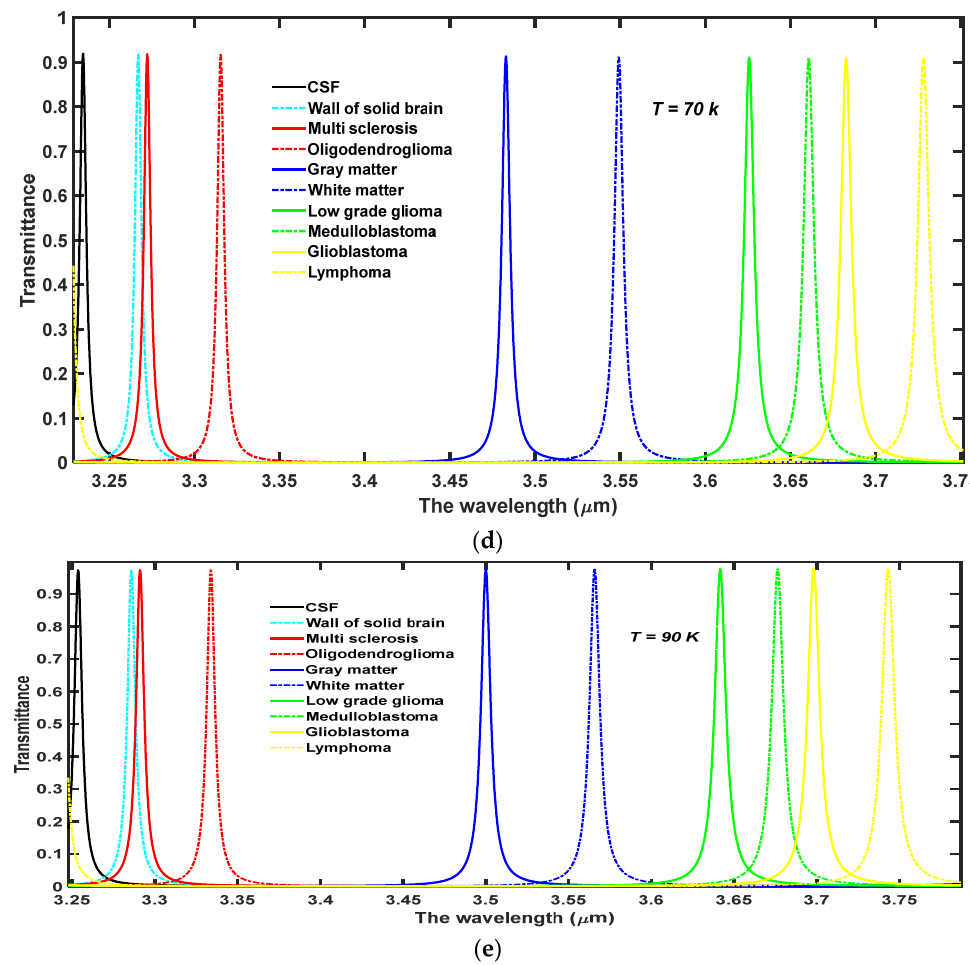
Figure 5. The temperature dependent transmittance spectra of 1D DPhC ( AB ) 2 CDC ( AB ) 2 corresponding to d 4 = 15 dd , η = 0.8 and θ = 63°. The cavity is infiltrated with ten different samples containing brain tissues. The ambient temperature (T) of nanocomposite buffer layers fabricated either side of cavity layer is fixed to ( a ) T = 10 K, ( b ) T = 30 K, ( c ) T = 50 K, ( d ) T = 70 K and ( e ) T = 90 K.